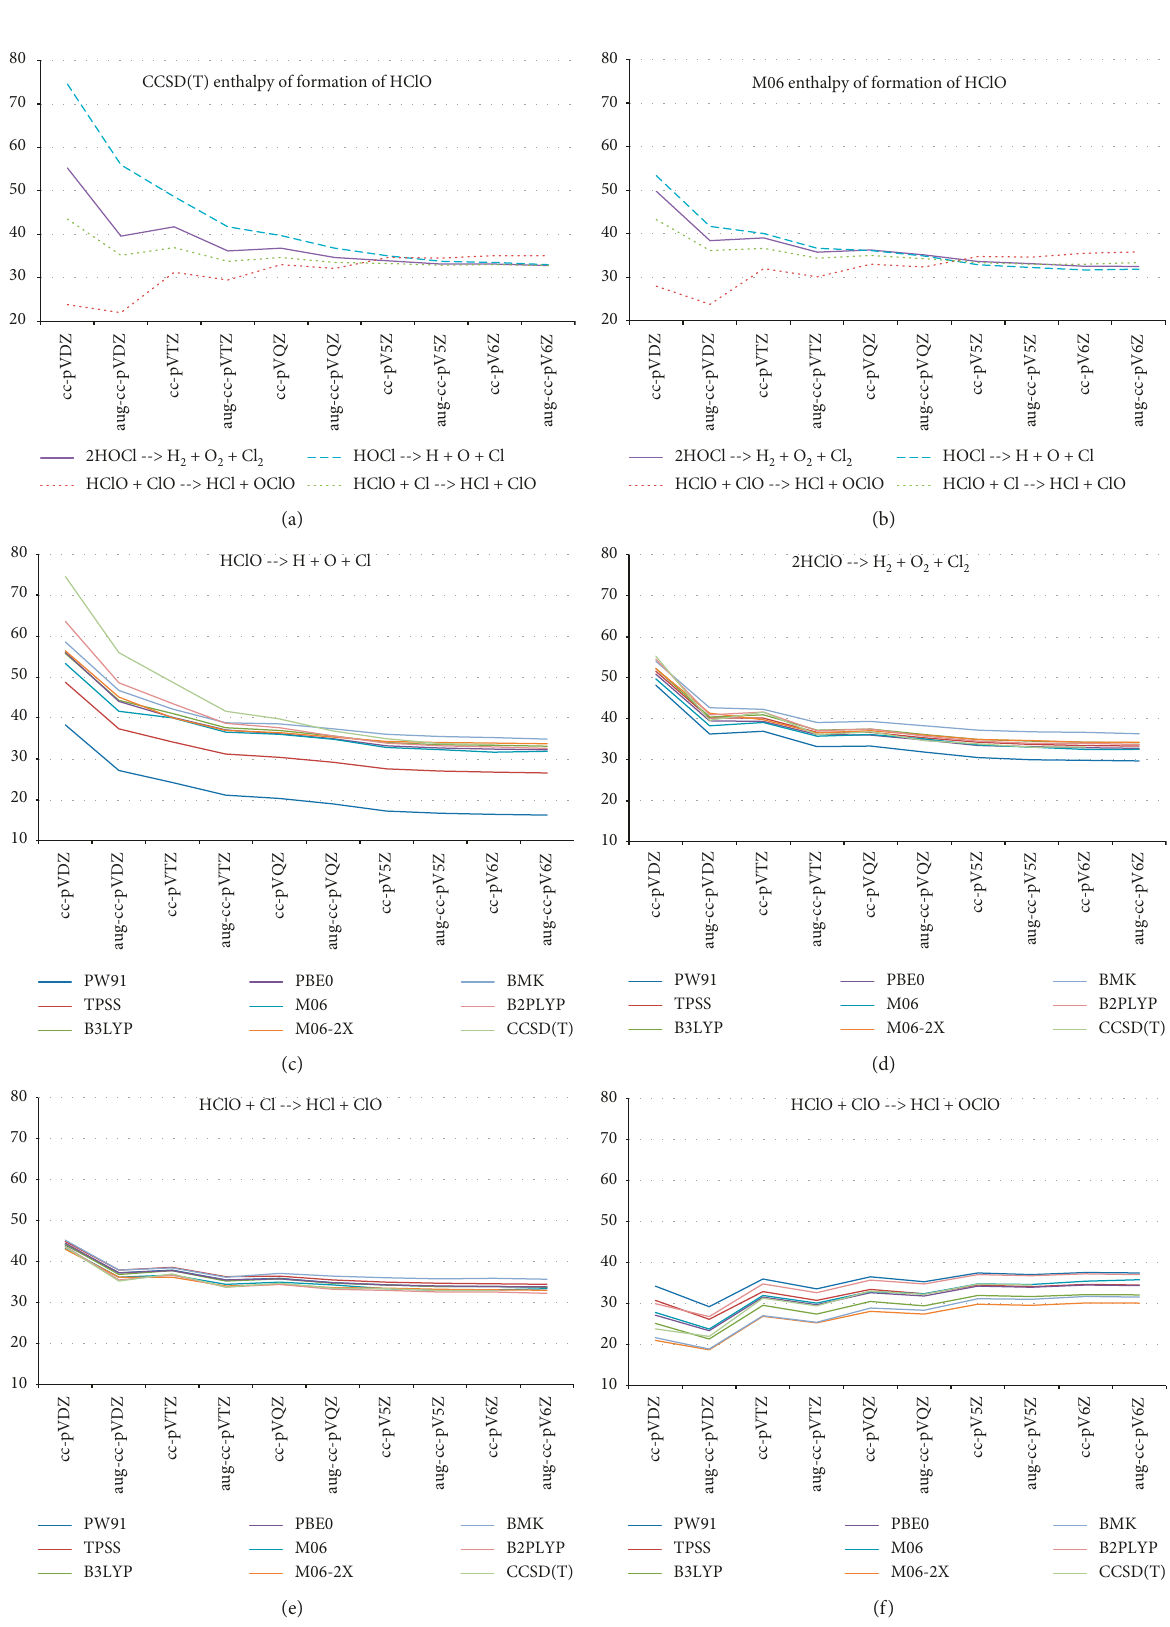
Figure 8: Convergence of the values of the enthalpy of formation of HClO (in kcal/mol) for different reactions and models. The CCSD(T) and M06 results are shown in the upper two panels for each of the four reactions considered. The lower four panels show the convergence of all methods for each one of the four